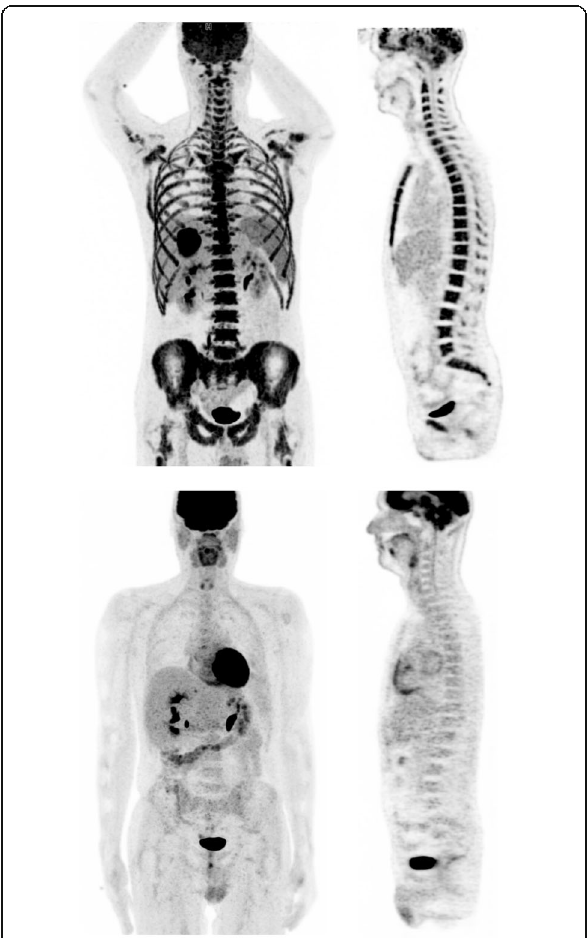
Fig. 4 FDG PET tracer uptake before (upper row) and after (lower row) surgery: after resection of the tumor FDG PET showed complete normalization of bone marrow